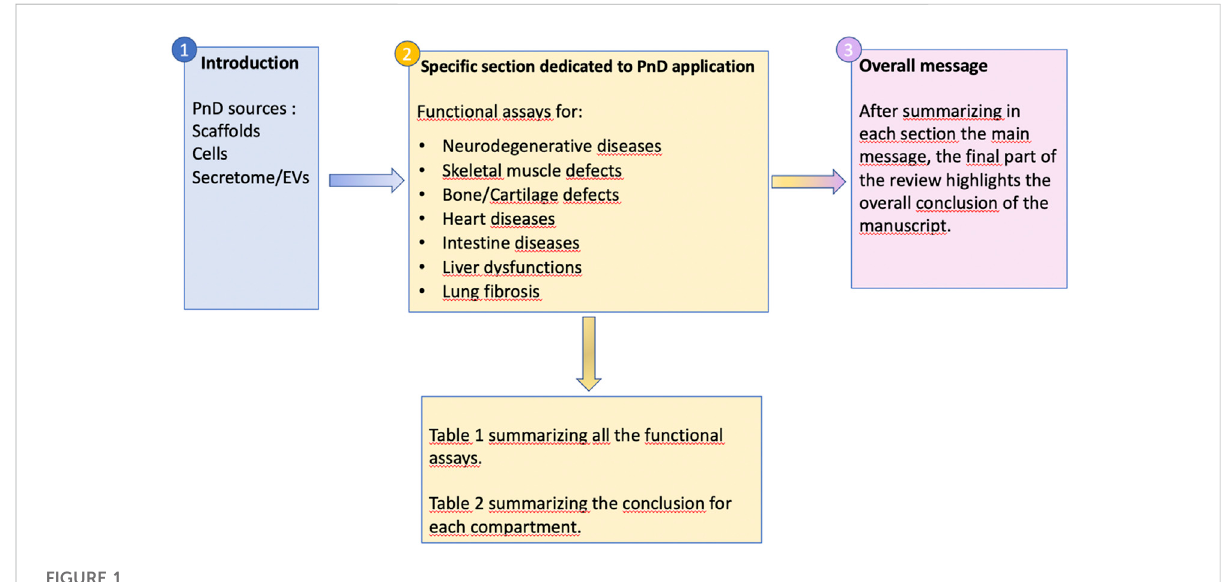
FIGURE 1 Flow chart of the manuscript